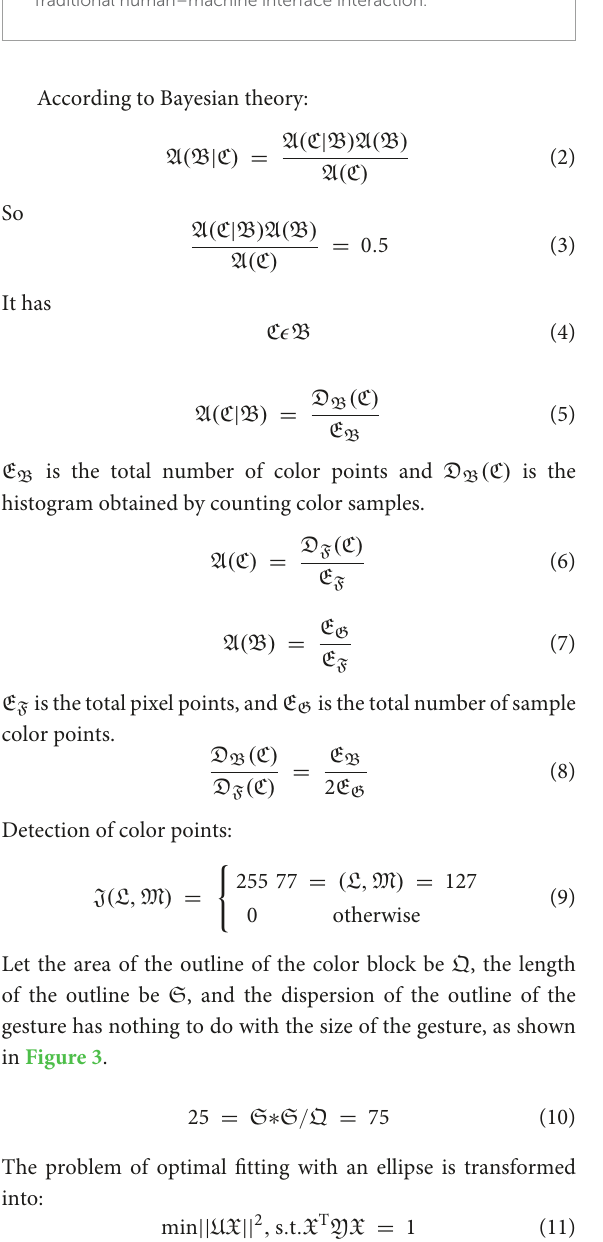
FIGURE3 Gesture profile